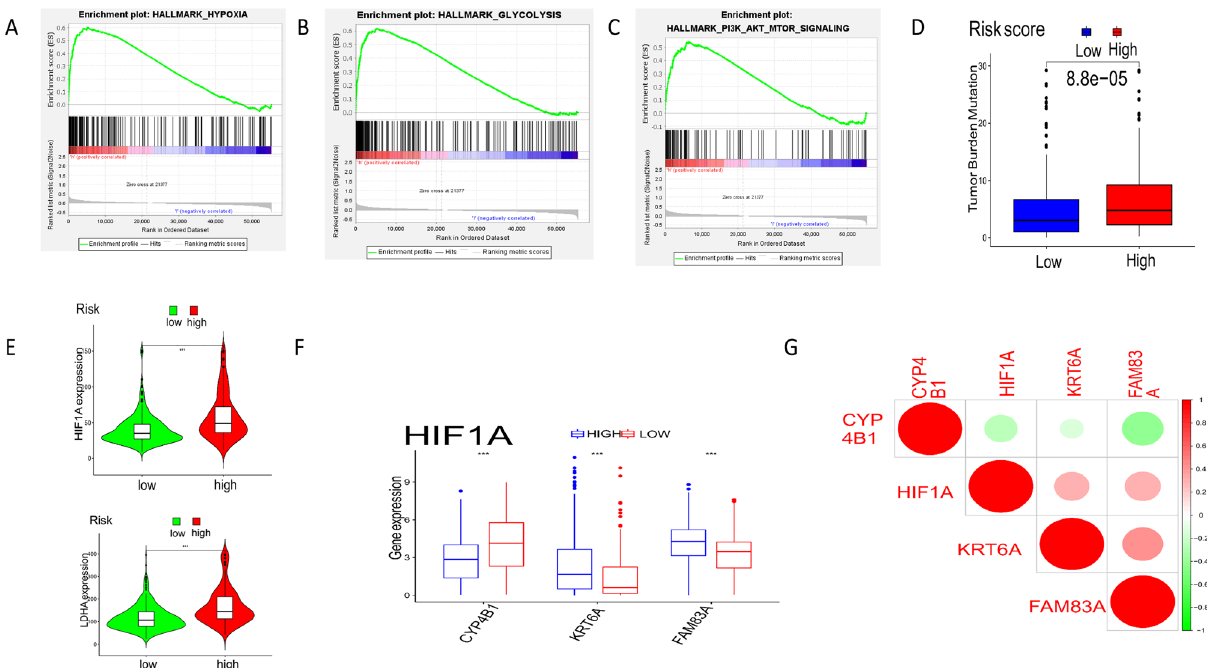
Figure 5. Effects of hypoxia in high and low-risk groups. ( A – C ), GSEA analysis showed that the high-risk group was enriched in hypoxia ( A ), glycolysis ( B ), and PI3K/Akt/mTOR ( C ) signaling pathway. ( D ) Tumor mutation load in different risk groups. ( E ) Expression levels of hypoxia-inducible factor HIF1A and hypoxia regulatory factor LDHA. ( F ) Distribution level of risk genes in high and low HIF1A expression groups. ( G ) Correlation between risk genes and